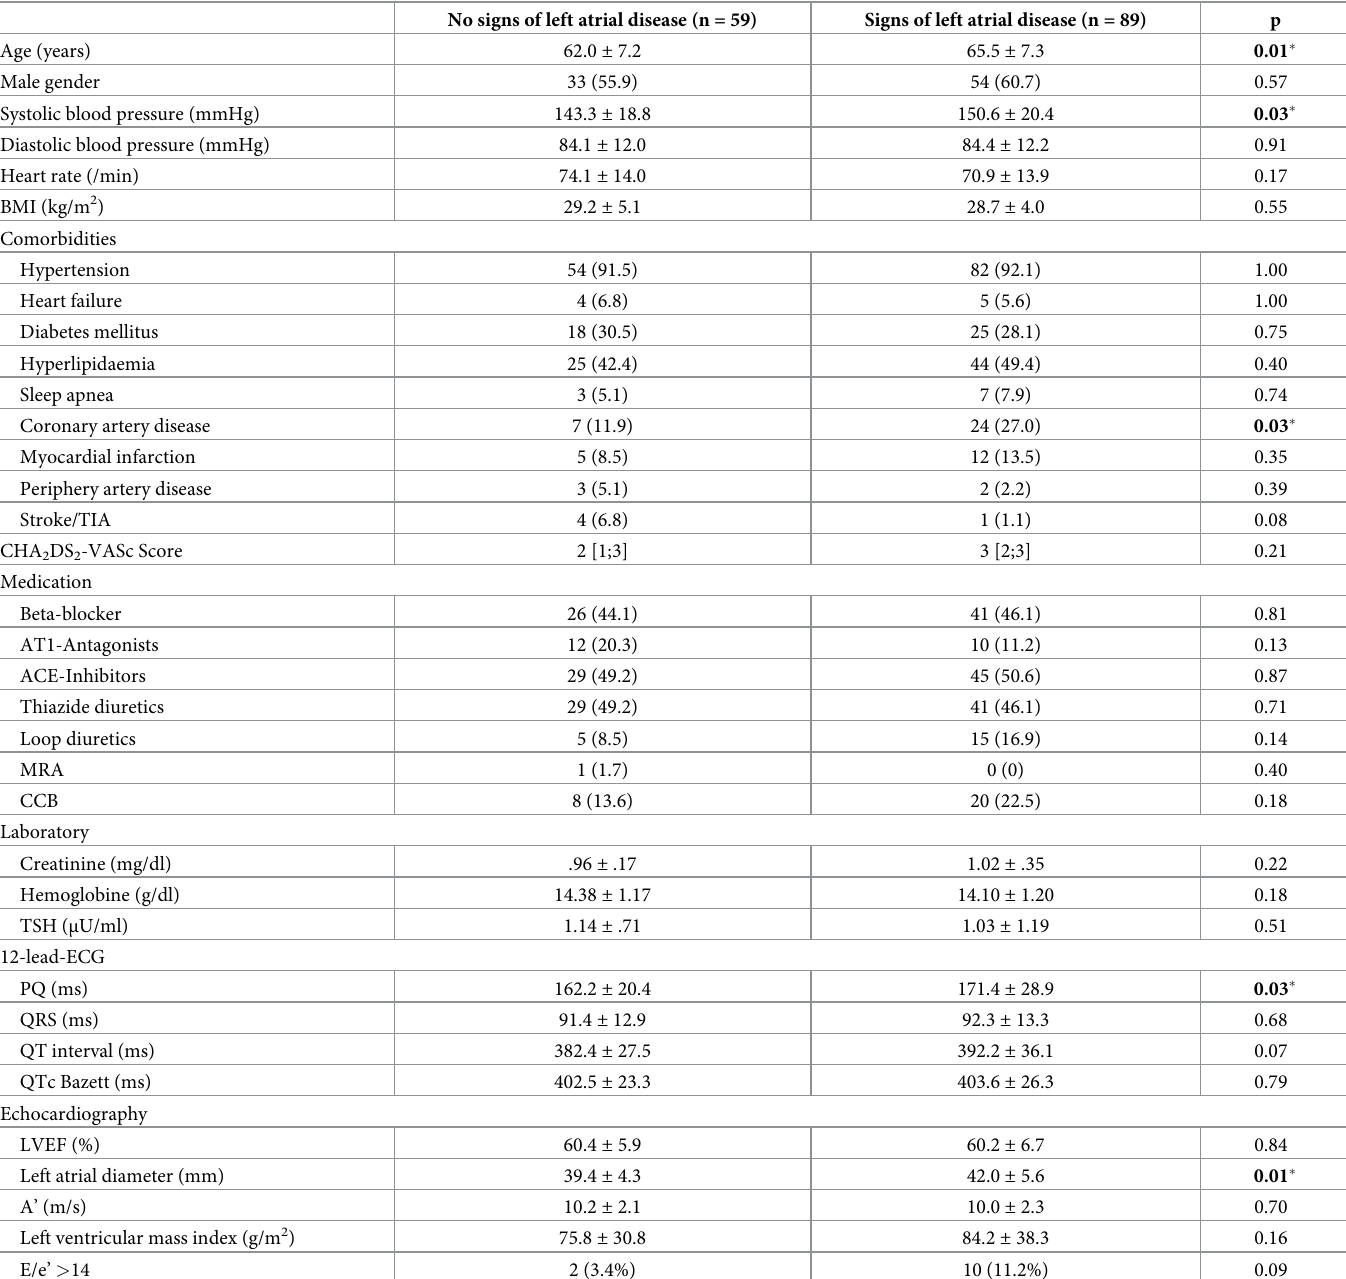
Table 1. Baseline characteristics for patients with and without signs of left atrial